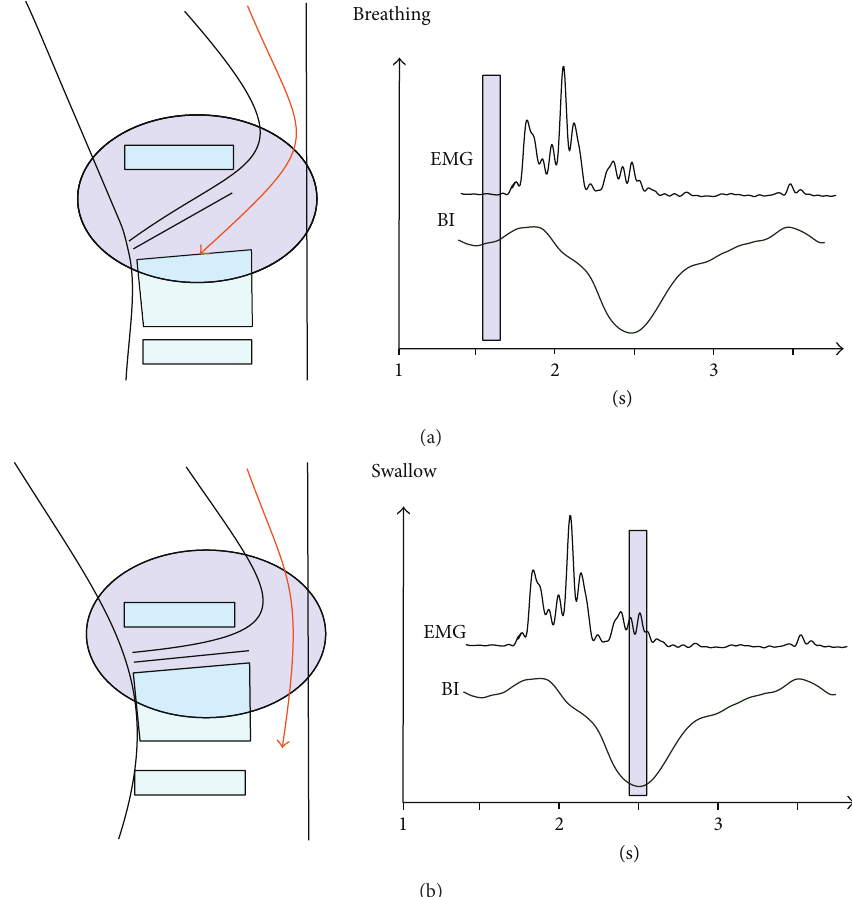
Figure 2: Schematic of bioimpedance measurement. (a) During breathing, the pharynx is filled with air and tissue resistance is consequently high. (b) On swallowing, the pharynx is closed through muscle action and resistance is